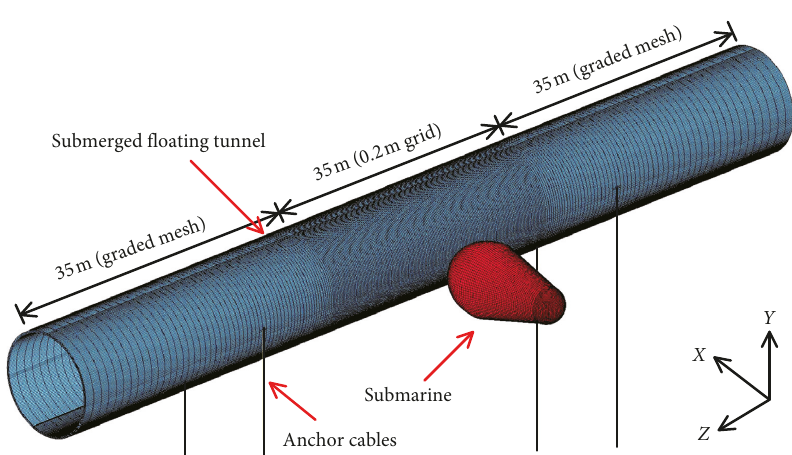
Figure 2: Finite element method model.